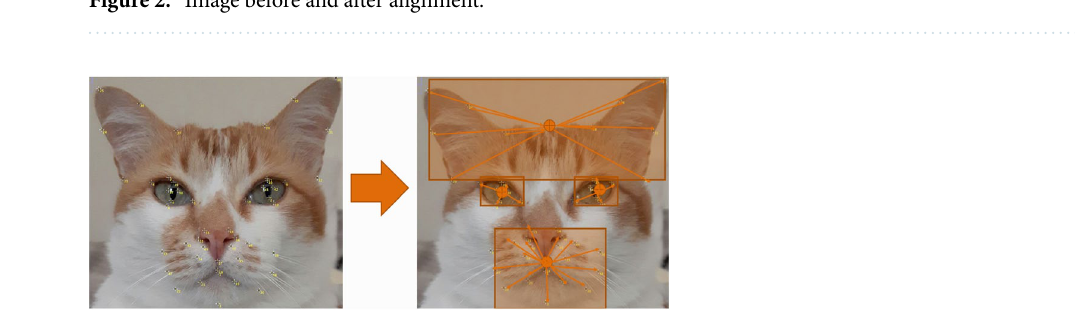
Figure 2. Image before and after alignment.